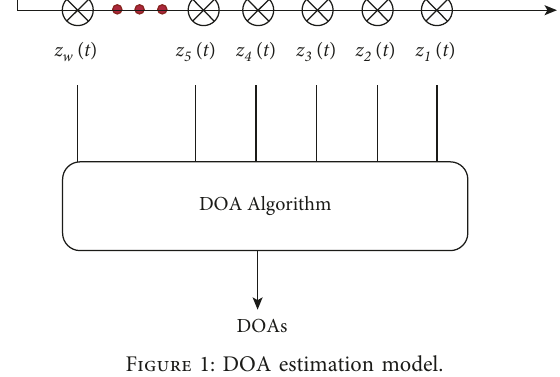
Figure 1: DOA estimation